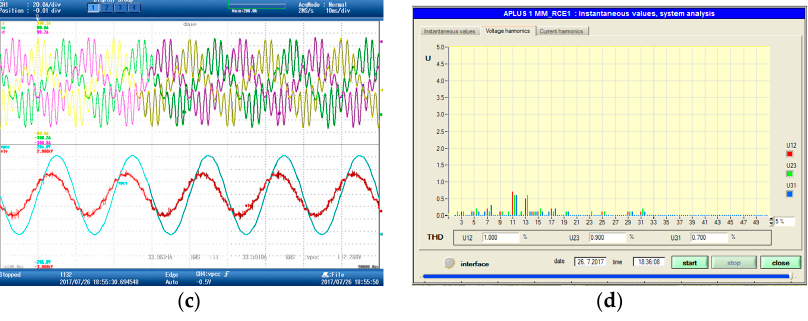
Figure 24. Experimental results of the ACISEF in a real AC grid. ( a ) The ACISEF provides 300 kVAR of reactive power and the active impedances at 550 Hz and 650 Hz are not enabled (top: converter currents at the low voltage side, bottom: Pcc voltage at 33 kV (blue) and PCC voltage at the low voltage side of the transformer (600 V) (red)). ( b ) Harmonic content of the grid voltage at the Pcc (33 kV side) with the active impedances not enabled. ( c ) The ACISEF provides 300 kVAR of reactive power and the active impedances at 550 Hz and 650 Hz (300 Ω for both harmonics) are enabled (top: converter currents at the low voltage side, bottom: Pcc voltage at 33 kV (blue) and PCC voltage at the low voltage side of the transformer (600 V) (red)). ( d ) Harmonic content of the grid voltage at the Pcc (33 kV side) with the active impedances enabled.